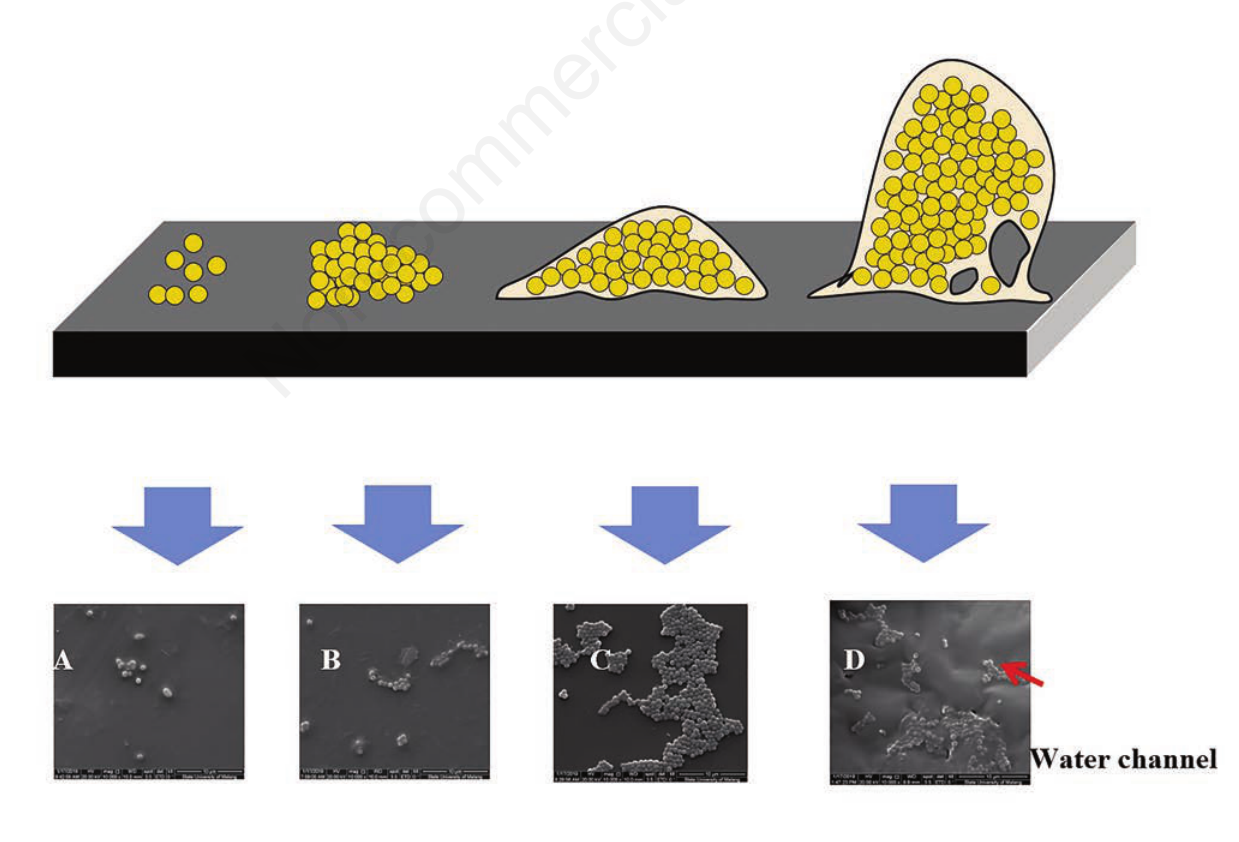
Figure 6. The result of SEM analysis for the development of S. aureus at (a) 0 hour biofilm, (b) 6 hours, (c) 11 hours, and (d) 17